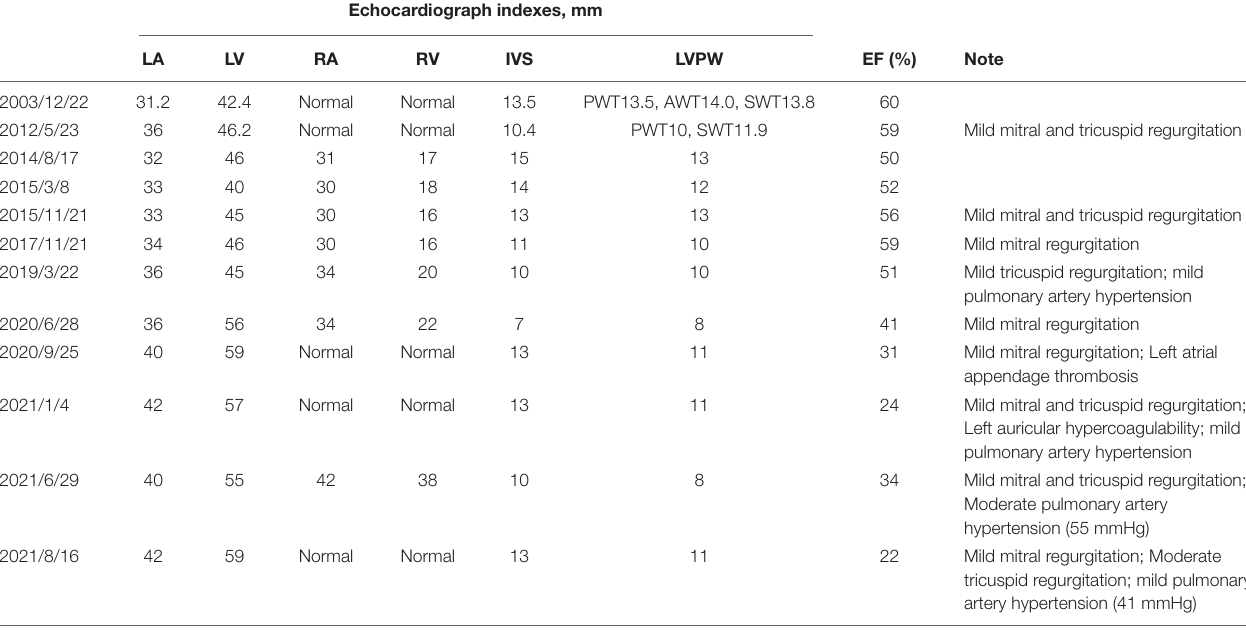
TABLE 1 | Echocardiograph indexes of Pt